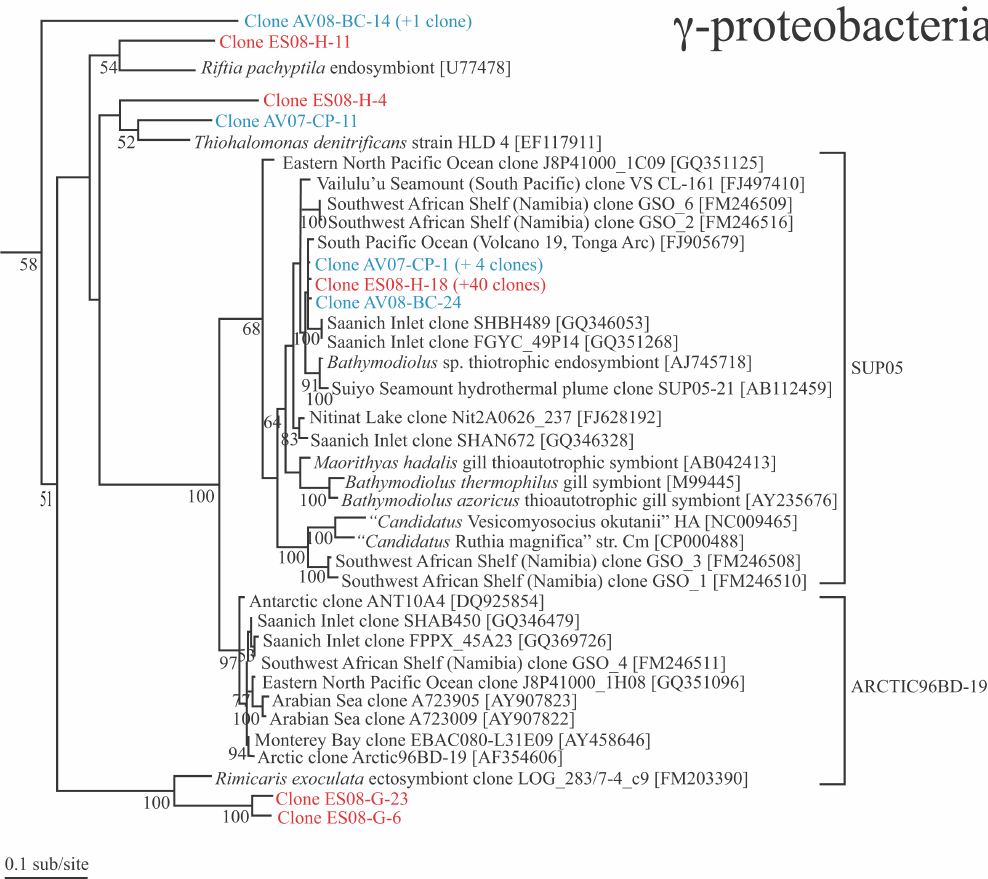
Fig. 6. Partial 16S rRNA gene γ -proteobacteria phylogenetic tree constructed using the maximum likelihood method implemented in PHYML. Clone prefixes were assigned as follows: the first letters indicate the vent fields: AV=Axial Volcano (in blue) and ES=Endeavour Segment (in red), followed by the year (07=2007 and 08=2008) and the last letters the diffuse vent sampled: CP=Cloud Pit, BC=Bag City, H=Hulk, and G=Godzilla. The last numbers indicate clones #. The number of clones that are ≥ 97% identical to a given hydrothermal vent clone is indicated in parentheses. GenBank accession numbers are provided (in brackets) for all other clones not sequenced in this study. The percentage of 100 bootstrap resamplings above 50% is indicated. The scale bar indicates the number of amino acid substitutions per site.